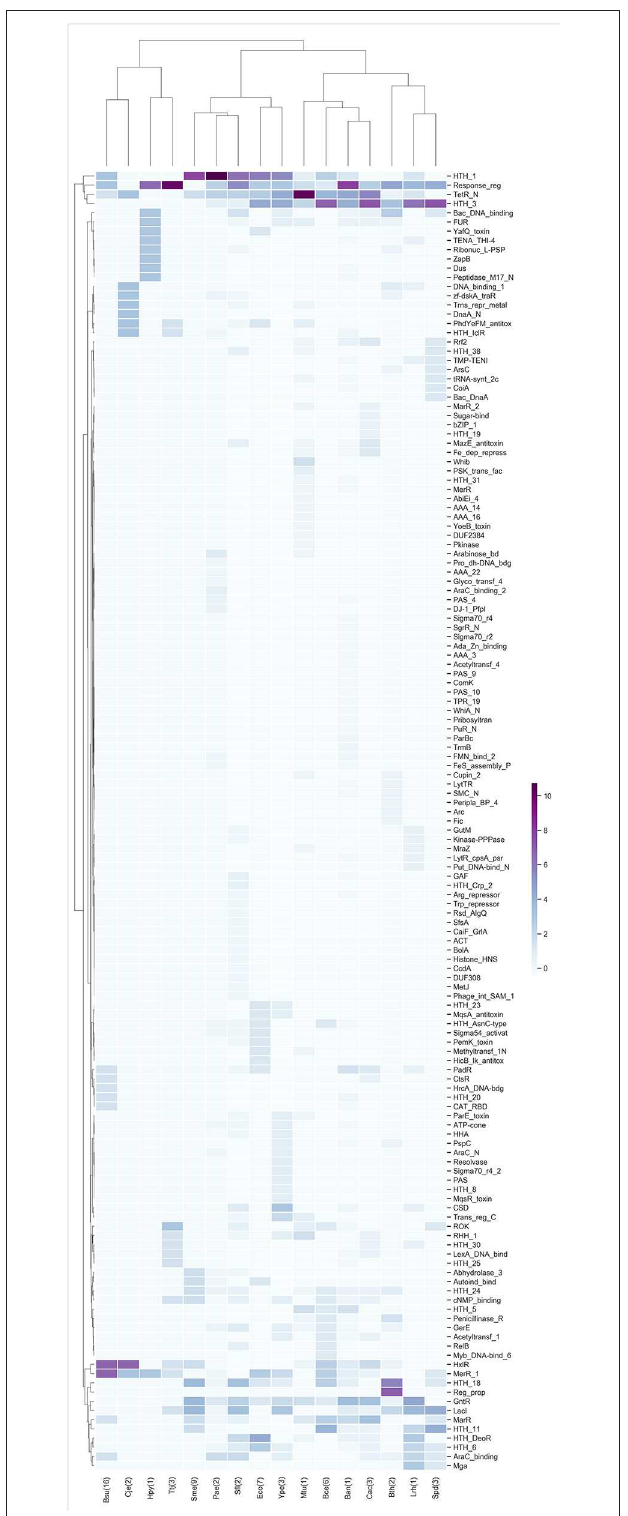
FIGURE 3 | TF families identified as frequent in the enriched modules. Z -score hierarchical clustering based on Euclidean distance measure and Ward’s method for linkage analysis. Each row represents the PFAM and each column represents the most enriched module for that bacterial